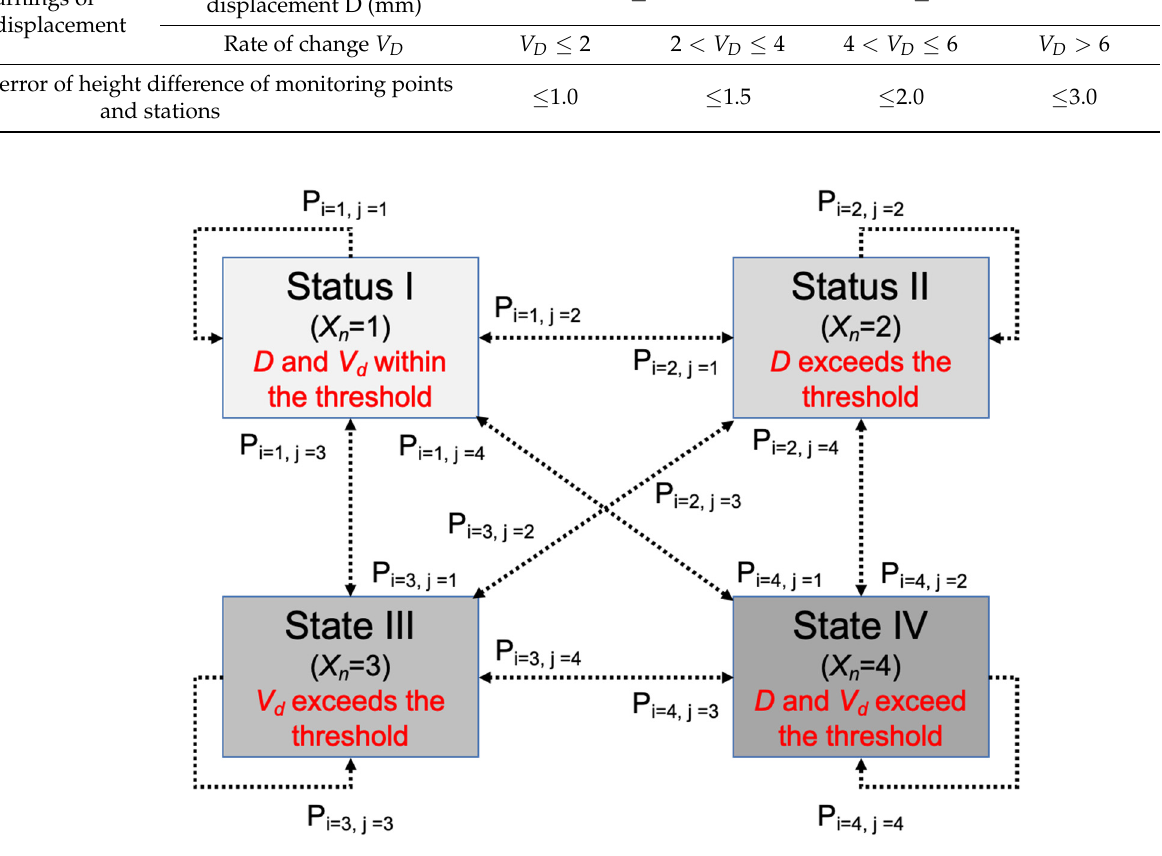
Figure 4. A state transition diagram during FPE based on Markov chain.